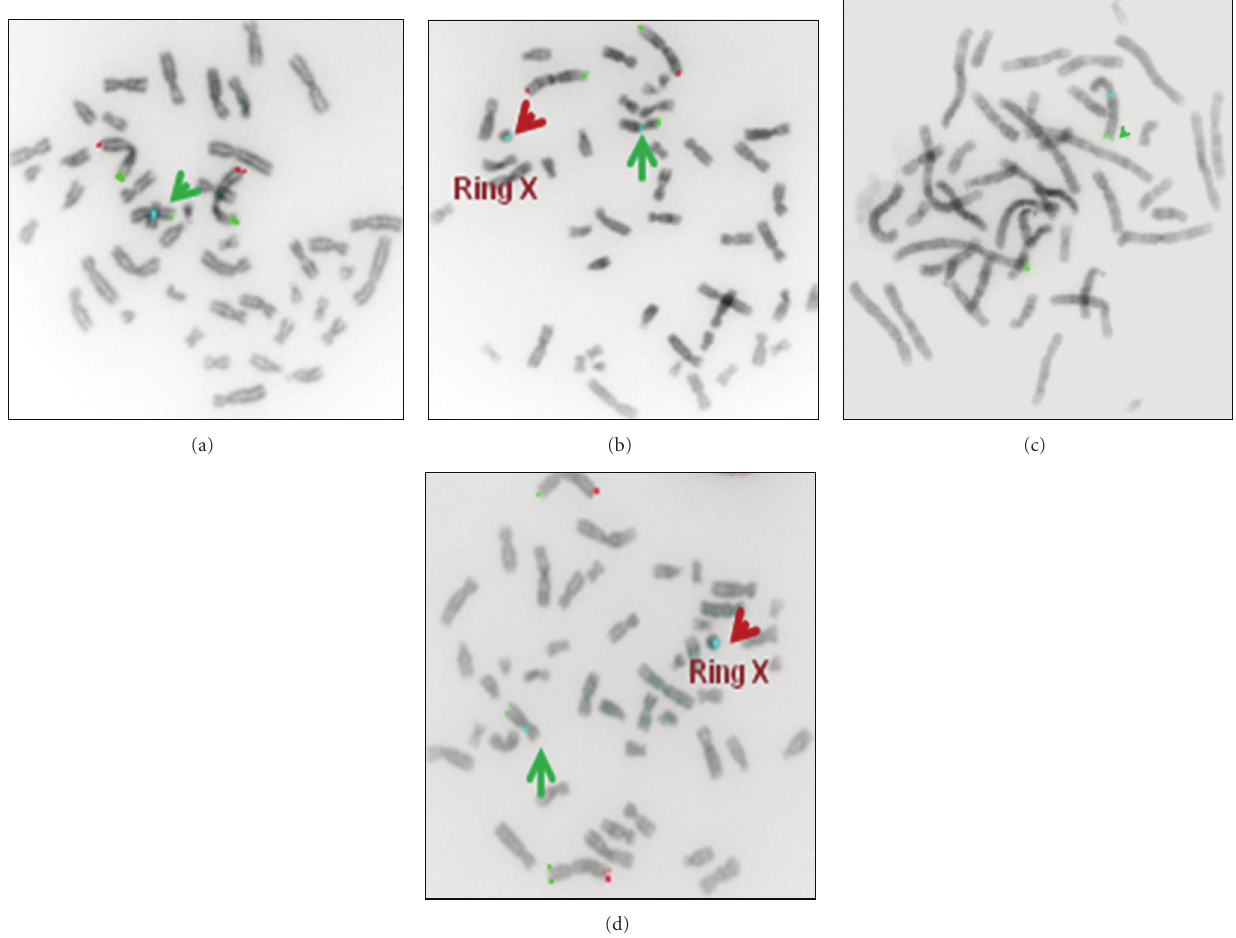
Figure 4: FISH of metaphase spread with the Vysis Telvysion probe, which hybridizes the Xp and Xq telomeres signals (a) and (c) shows Xp and Xq telomere signals on 45, XO metaphase spread, whereas (b) and (d) show Xp and Xq signals on normal chromosome X, and loss of Xp and Xq on 46,X+ringX metaphase